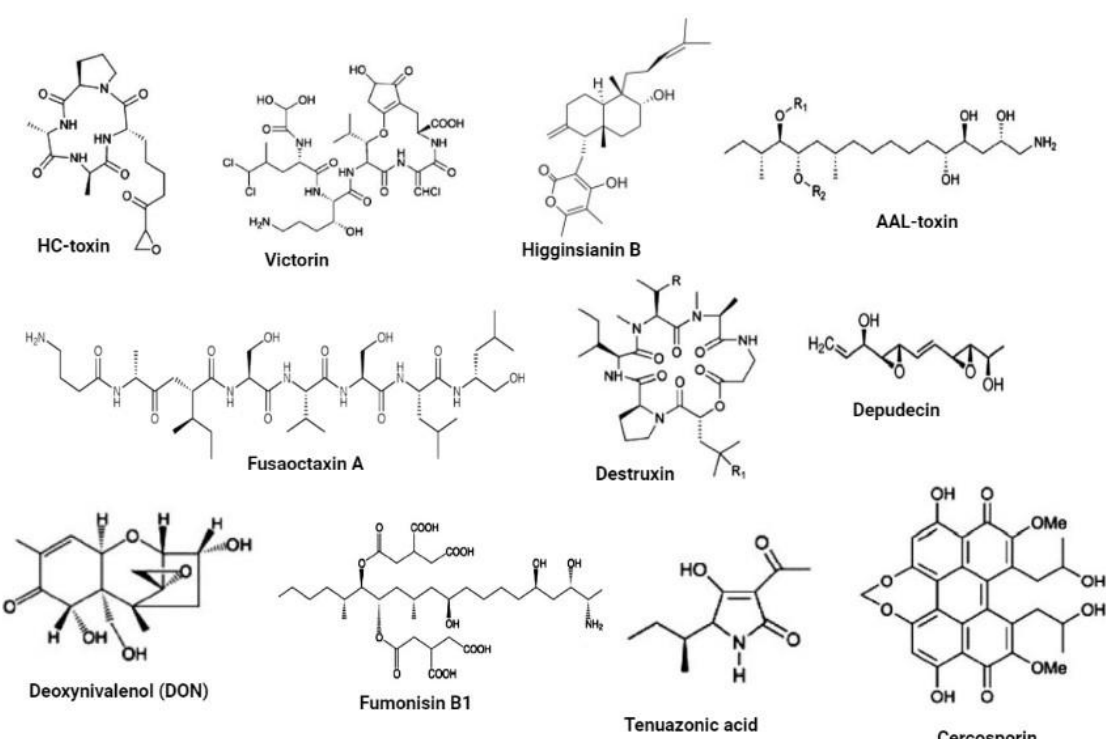
Figure 1. Fungal SM effectors. Host-specific toxins include HC-toxin, victorin, higginsianin B, AAL- toxin, Fusaoctaxin A, destruxin, depudecin. Host non-specific toxins include DON, Fumonisin B1, tenuazonic acid, and cercosporin. Adapted from [51 – 54].